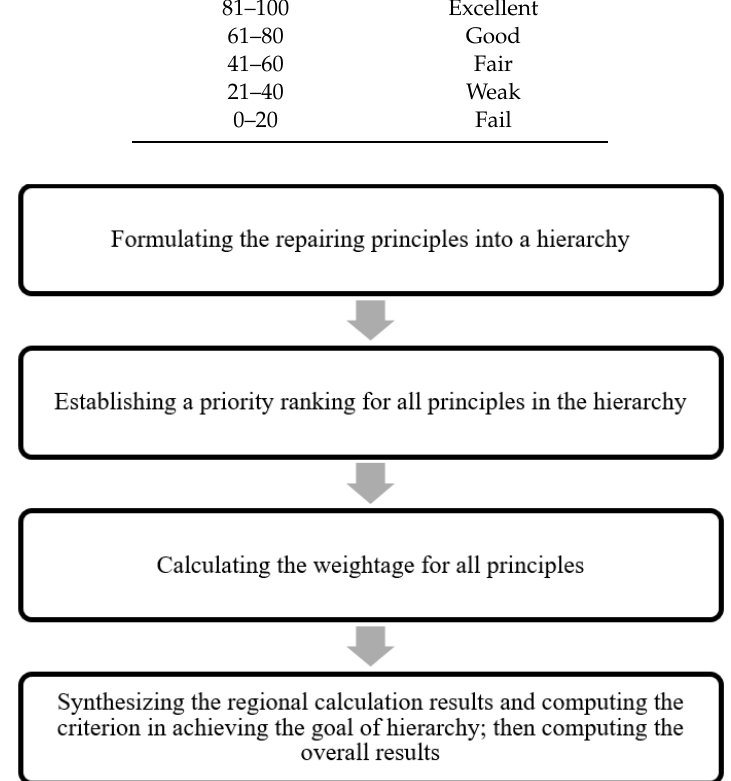
Figure 9. Weighting the repairing principles with priority ranking.